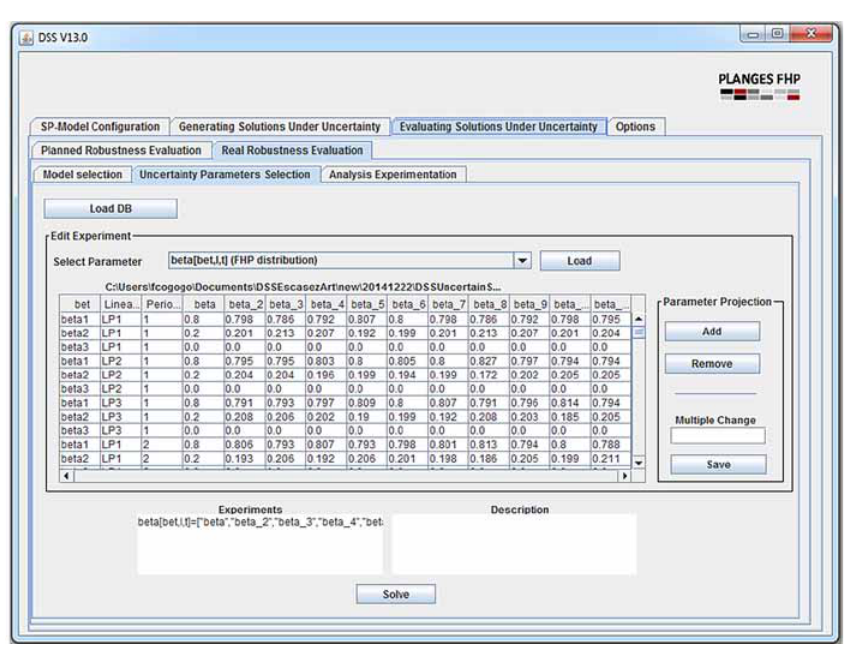
Fig. 9. The “Uncertain Parameters Selection” option for the “Real Robustness Evaluation” DSS